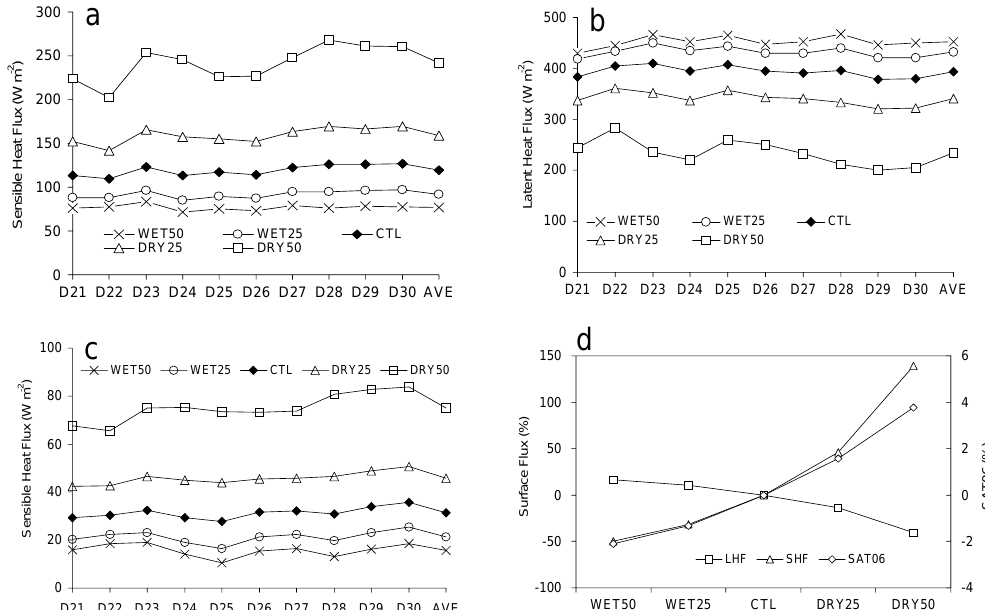
Figure 10. The area-averaged sensible and latent heat fluxes and SAT06. (a) The 06:00UTC sensible heat flux for individual simulations with a 10-day average (AVE) for each group of simulations. (b) The same as (a) but for latent heat flux. (c) The same as (a) but for the 24h mean sensible heat flux (SHF). (d) The relative differences (%) in the 10-day mean 24h averaged sensible heat flux (SHF), latent heat flux (LHF) and SAT06 compared to